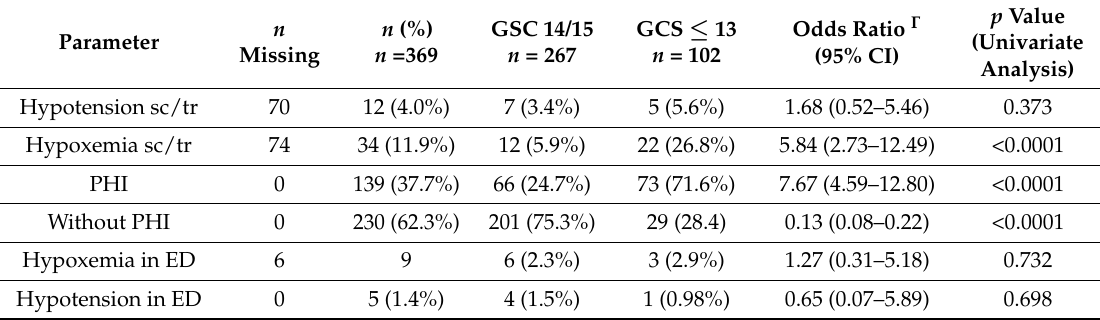
Table 4. Parameters of surviving patients with regained consciousness (Glasgow Coma Scale 14 and 15) and impaired consciousness (Glasgow Coma Scale ≤ 13) at 14 days.